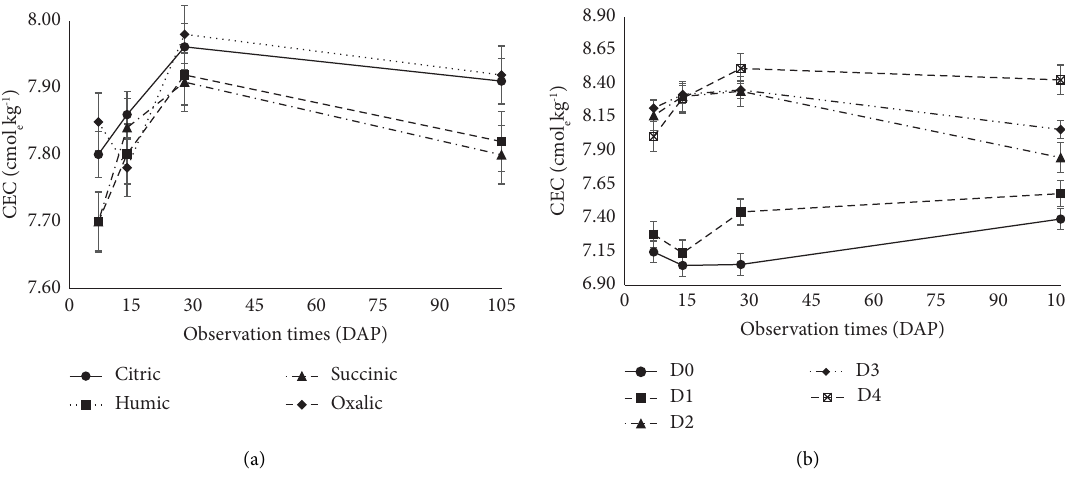
Figure 3: Efect of OA type (a) and OA concentration levels (b) on soil CEC at some observation times.